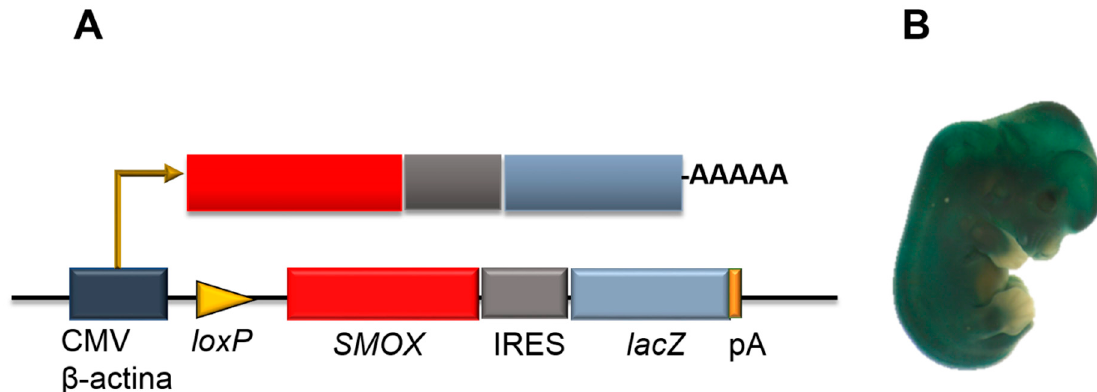
Figure 6. Total-Smox mouse line. ( A ) Scheme of the genetic construct of the Total-Smox mouse line upon recombination of the loxP sites by Cre recombinase. The β -actin/Cytomegalovirus (CMV) fusion promoter drives the ubiquitous expression of the SMOX gene and the lacZ reporter gene. IRES: internal ribosome entry site. ( B ) LacZ staining of Total-Smox embryo.